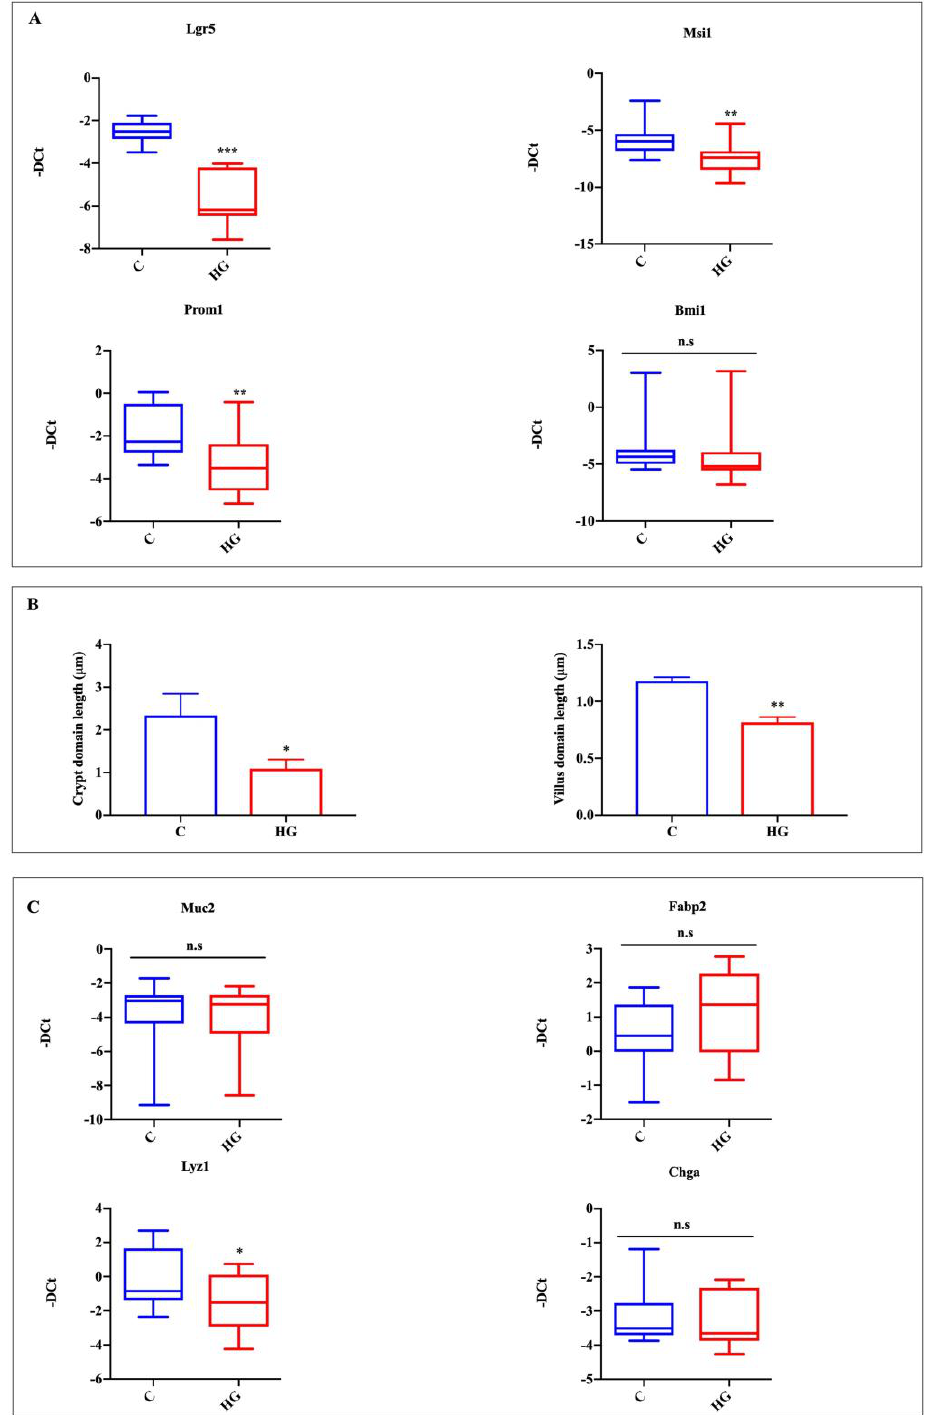
Figure 3. Action of high glucose exposure on intestinal organoid proliferation and specific intestinal epithelial lineage marker expression. Lgr5 and Msi1, proliferating cells, and stem cells; Prom1, TA cells; Bmi1, +4 cells ( A ); crypt domain length and villus domain length ( B ); Muc2, goblet cells; Fabp2, enterocytes; Lyz1, Paneth cells; ChgA, EECs ( C ). Data generated from three biological replicates from five mice. Unpaired Student t -test: * p < 0.05, ** p < 0.01, *** p < 0.001; n.s. not significant. C = Control (17.5 mM glucose). HG = High Glucose (35 mM glucose).